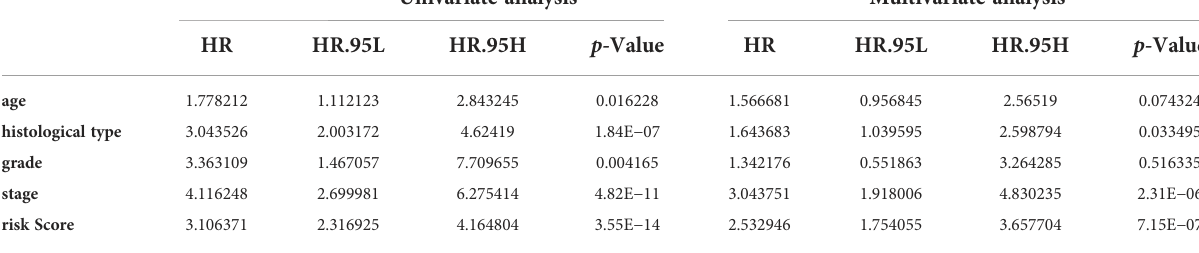
TABLE 3 Independent prognostic analysis of entire TCGA